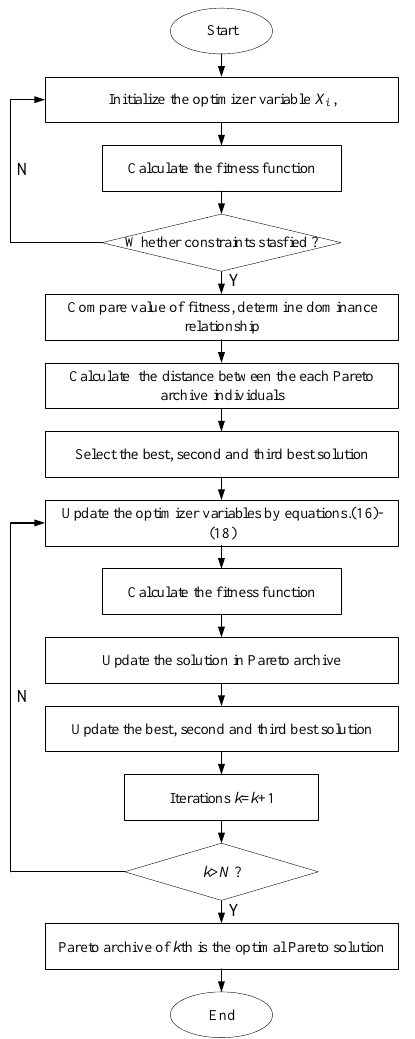
Figure 11. The optimization process for a successive start-up strategy.